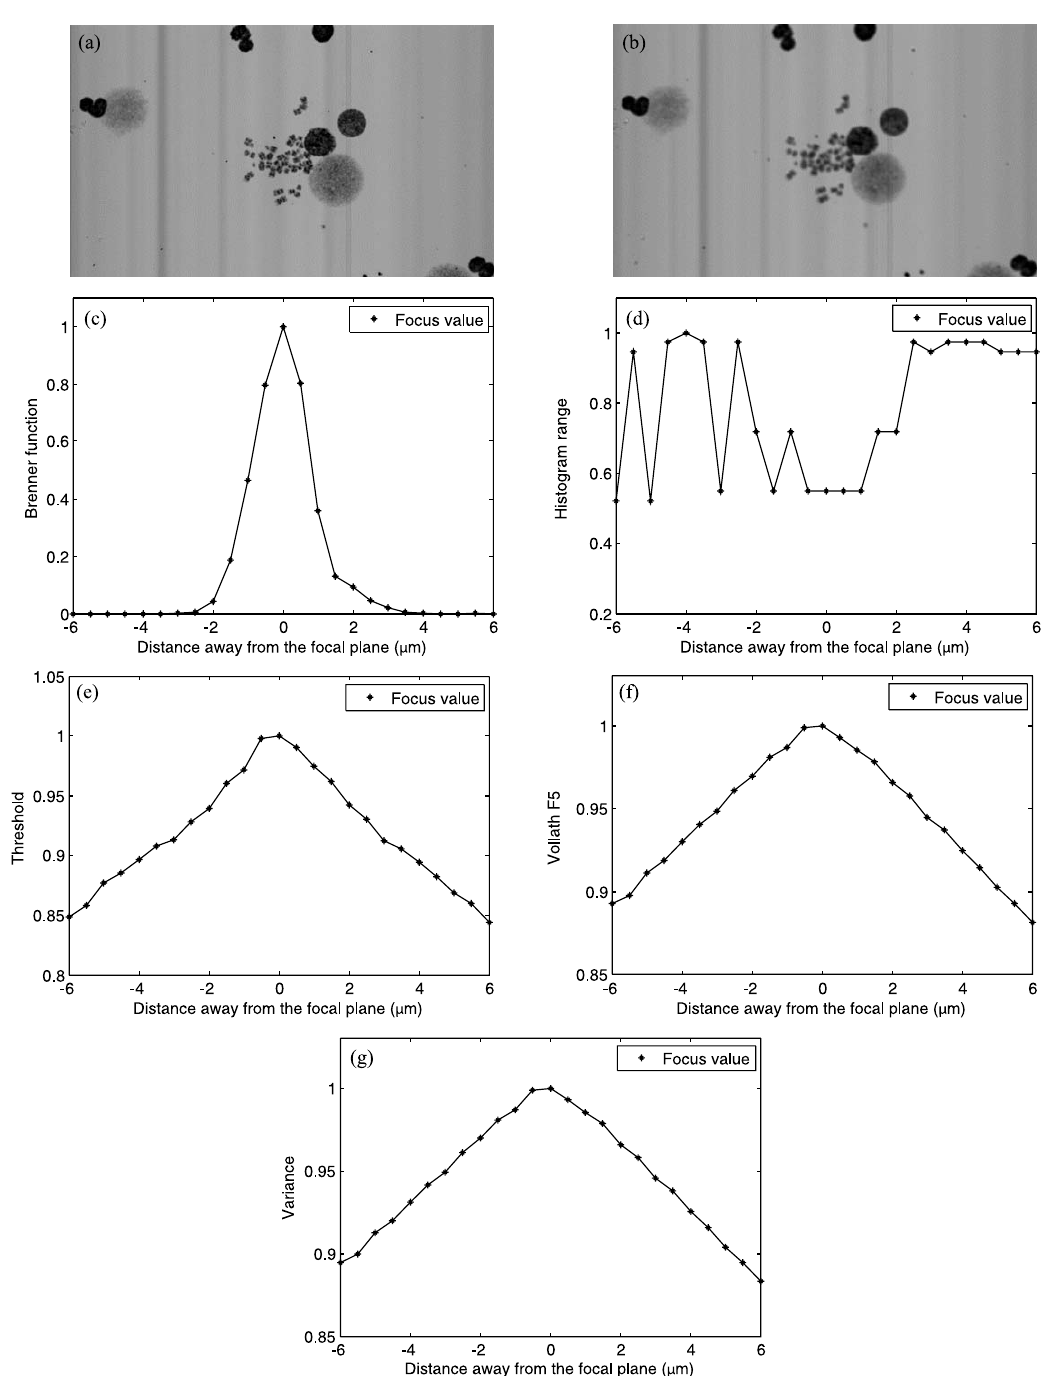
Fig. 2. An example of autofocus functions performed on micorsopic images of a pathlogical cell acquried from bone marrow sample. Image (a) and (b) are captured at in-focused position, and 3 (cid:2) m away from the focal plane, respectively. The image (b) is blurred as compared to the in-focused image in (a). The Brenner function (c), threshold pixel counting (e), Vollath F5 (f), and variance (g) successfully select the focal position. Histogram range (d), however, fails to locate the focal